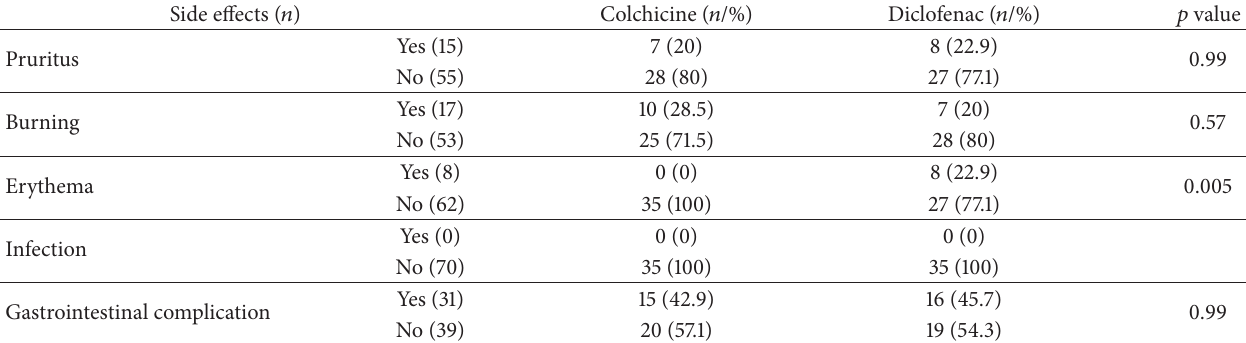
Table 3: Frequency of the incidence of complications during treatment in both